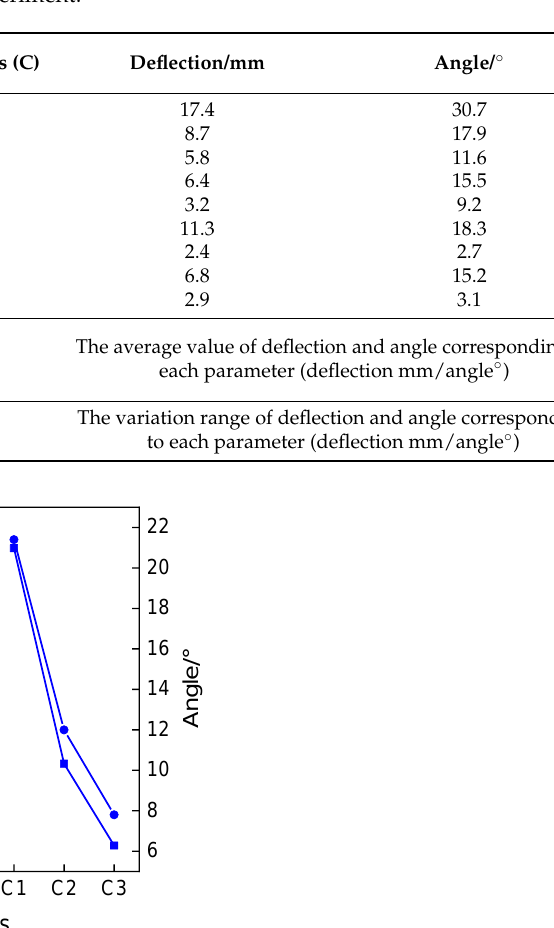
Table 4. Results of the orthogonal experiment.